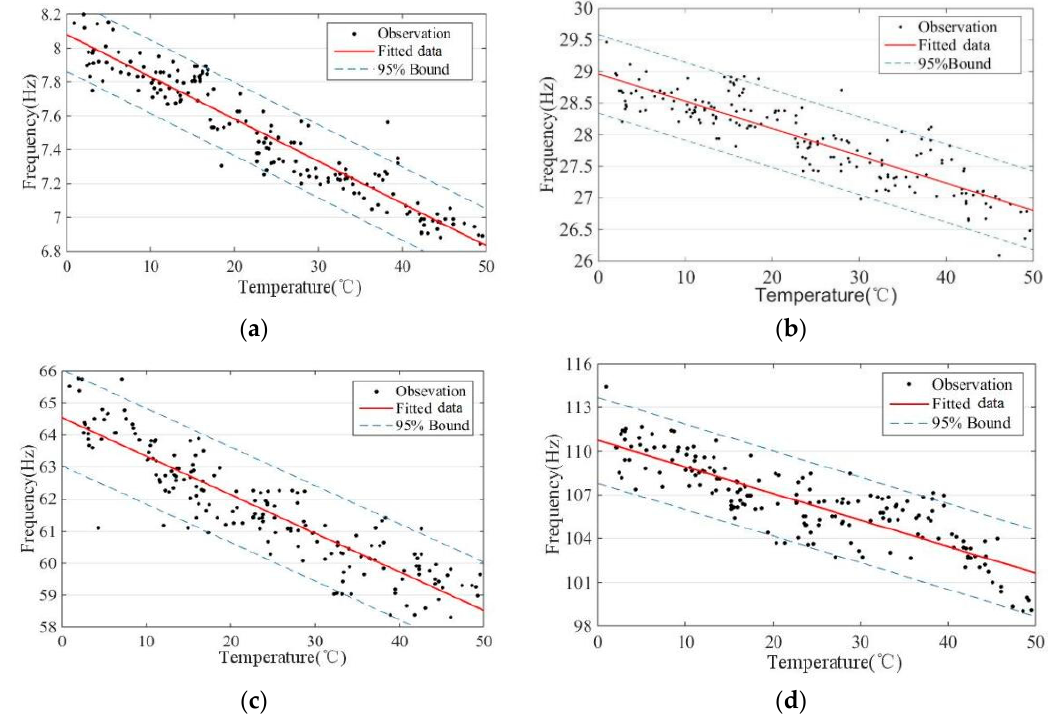
Figure 8. Frequencies vs. temperature. ( a ) 1st mode. ( b ) 2nd mode. ( c ) 3rd mode. ( d ) 4th mode.